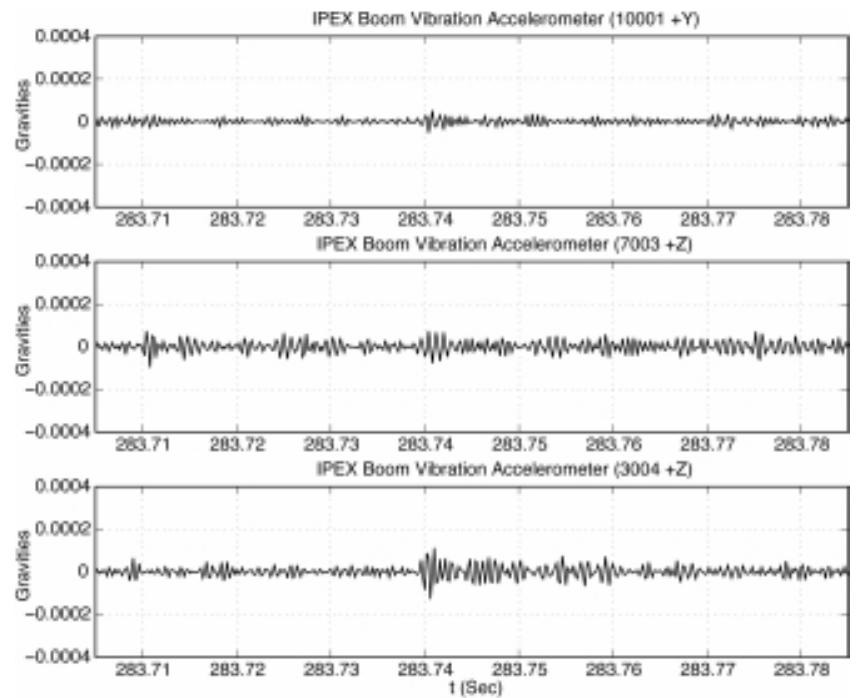
Fig. A11. Event 4 Nodes 3004, 7003 &